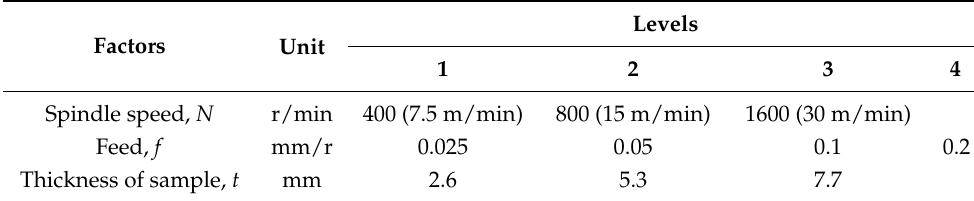
Table 4. Levels of the variables used in the